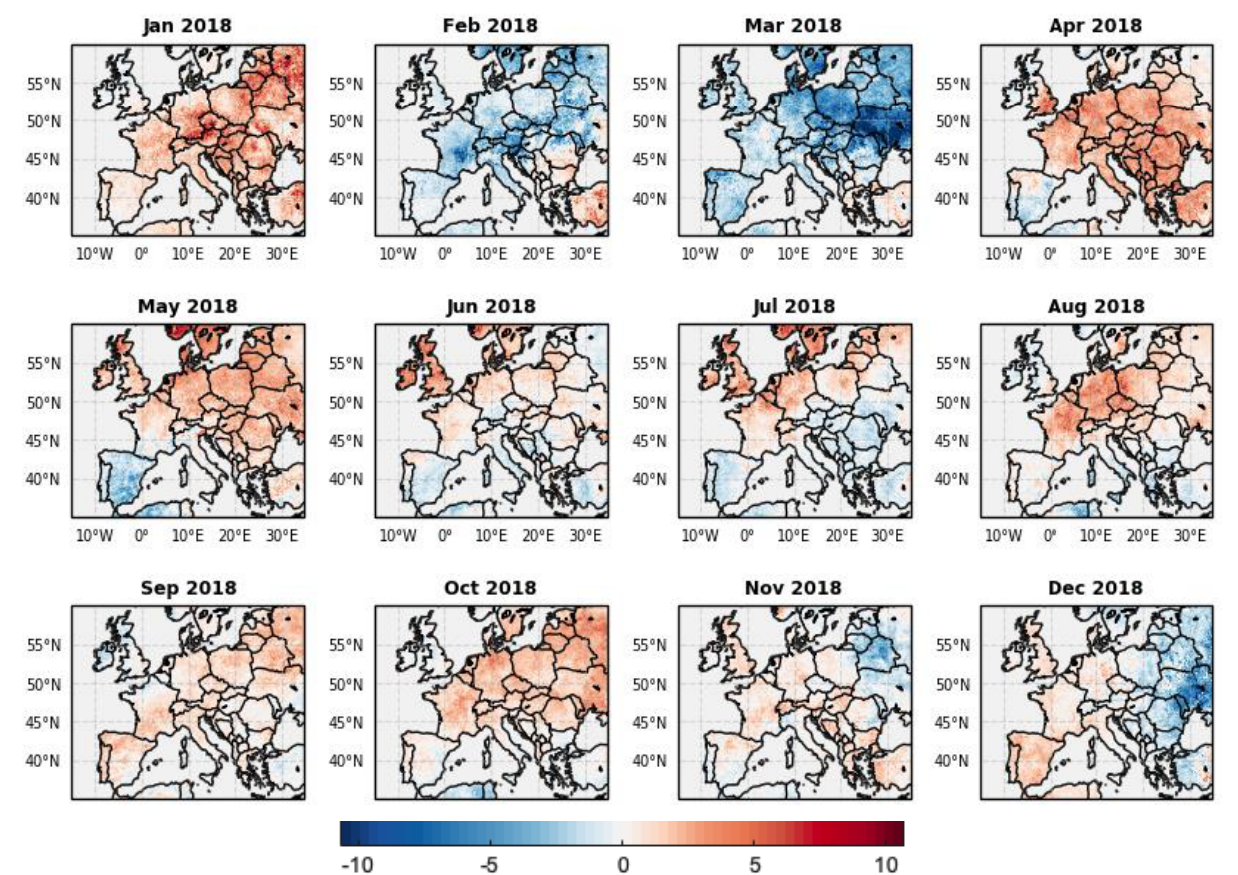
Figure 6. As in Figure 3 but considering MODIS LST (MYD11). The number of months in 2018 with average MODIS LSTs corresponding to the highest anomaly across the whole data record is shown in Figure 7. Again, as with to Figure 4, record-breaking LST anomalies were reached in 4 months over large areas of Northern Europe, with some pixels over the Baltic countries and Poland showing record-breaking LSTs over five months. In the Mediterranean regions, the overall pattern is more scattered, showing regions where no record-breaking LSTs were measured and others where 2018 obtained the highest values in 2 – 3 months.